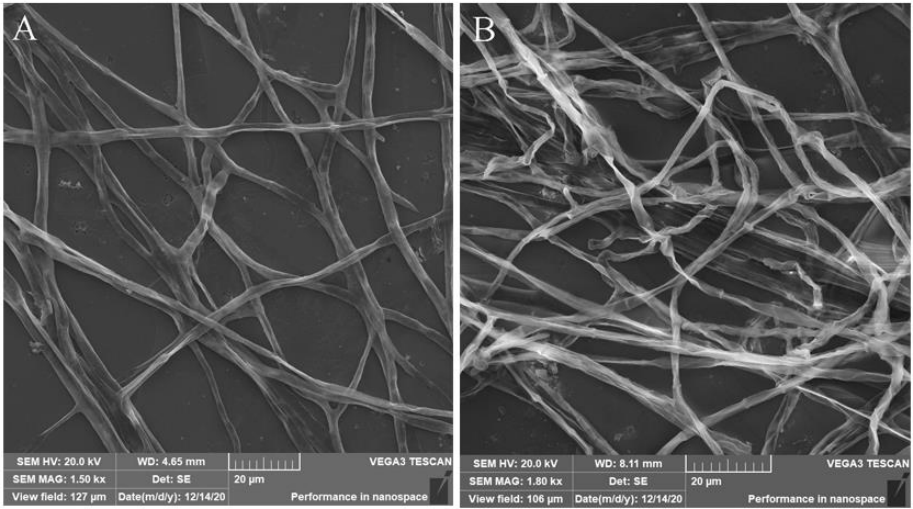
Figure 2. SEM images of F. solani mycelia. ( A ) Control, treatment with 30% ethanol. ( B ) Treatment with 10 mg/mL GRE.